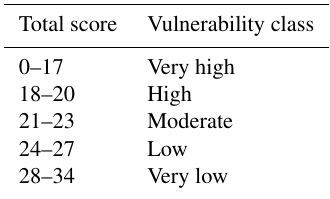
Table 3. Total score and vulnerability classes (“very high”, “high”, “moderate”, “low”, “very